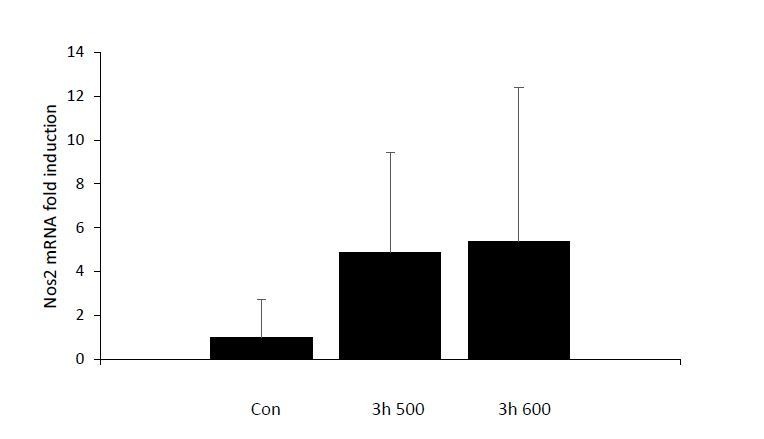
Induction of Nos2 mRNA was too variable and had too low FPKM to be statistically significant.